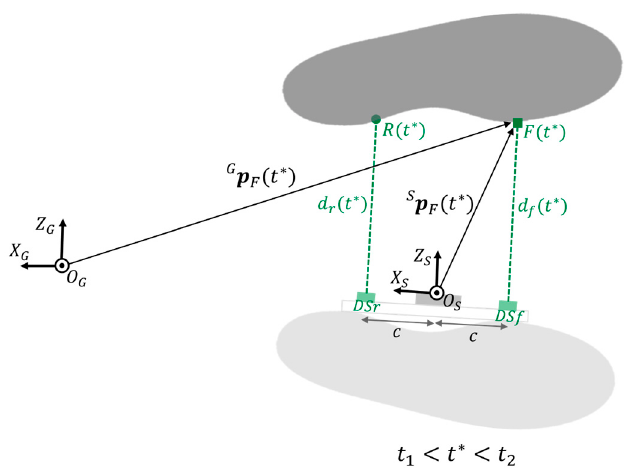
Figure 7. During t 1 < t < t 2 the non-instrumented foot (dark grey) is in stance phase, while the instrumented foot (light grey) is in swing phase. (cid:1856) (cid:3033) ( t* ) and (cid:1856) (cid:3045) ( t* ) are the distances recorded by the front and rear distance sensors (DSr and DSf) at t*. R ( t* ) and F( t* ) are the points of the medial side of the non-instrumented foot detected by the DS. (cid:1855) is the distance between each DS and the origin O S . For instance, the position of point F( t* ) with respect to CS S , (cid:2198) (cid:3020) (cid:3007) ((cid:1872) ∗ ), is calculated by means of geometrical rules exploiting (cid:1856) (cid:3033) ( t* ) and c . Then, the position vector (cid:2198) (cid:3008) (cid:3007) ((cid:1872) ∗ ) is computed to describe the point F( t* ) with respect to the global coordinate system CS G .